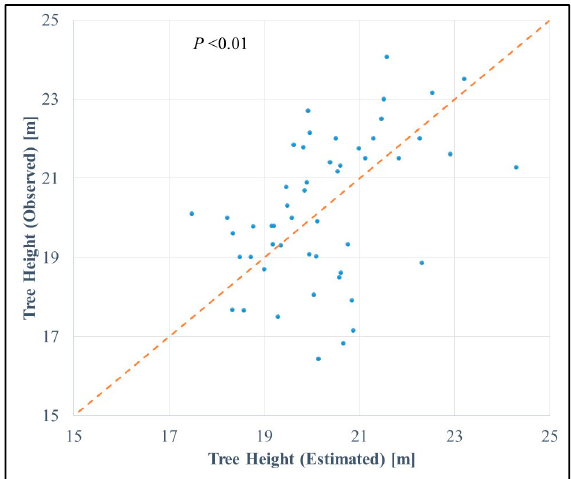
Figure 4. The relationship between estimated and observed tree heights. The dotted line in the center indicates 1:1. The Root Mean Square Error (RMSE) was calculated as 1.712 m (R 2 = 0.2076, linear trend).